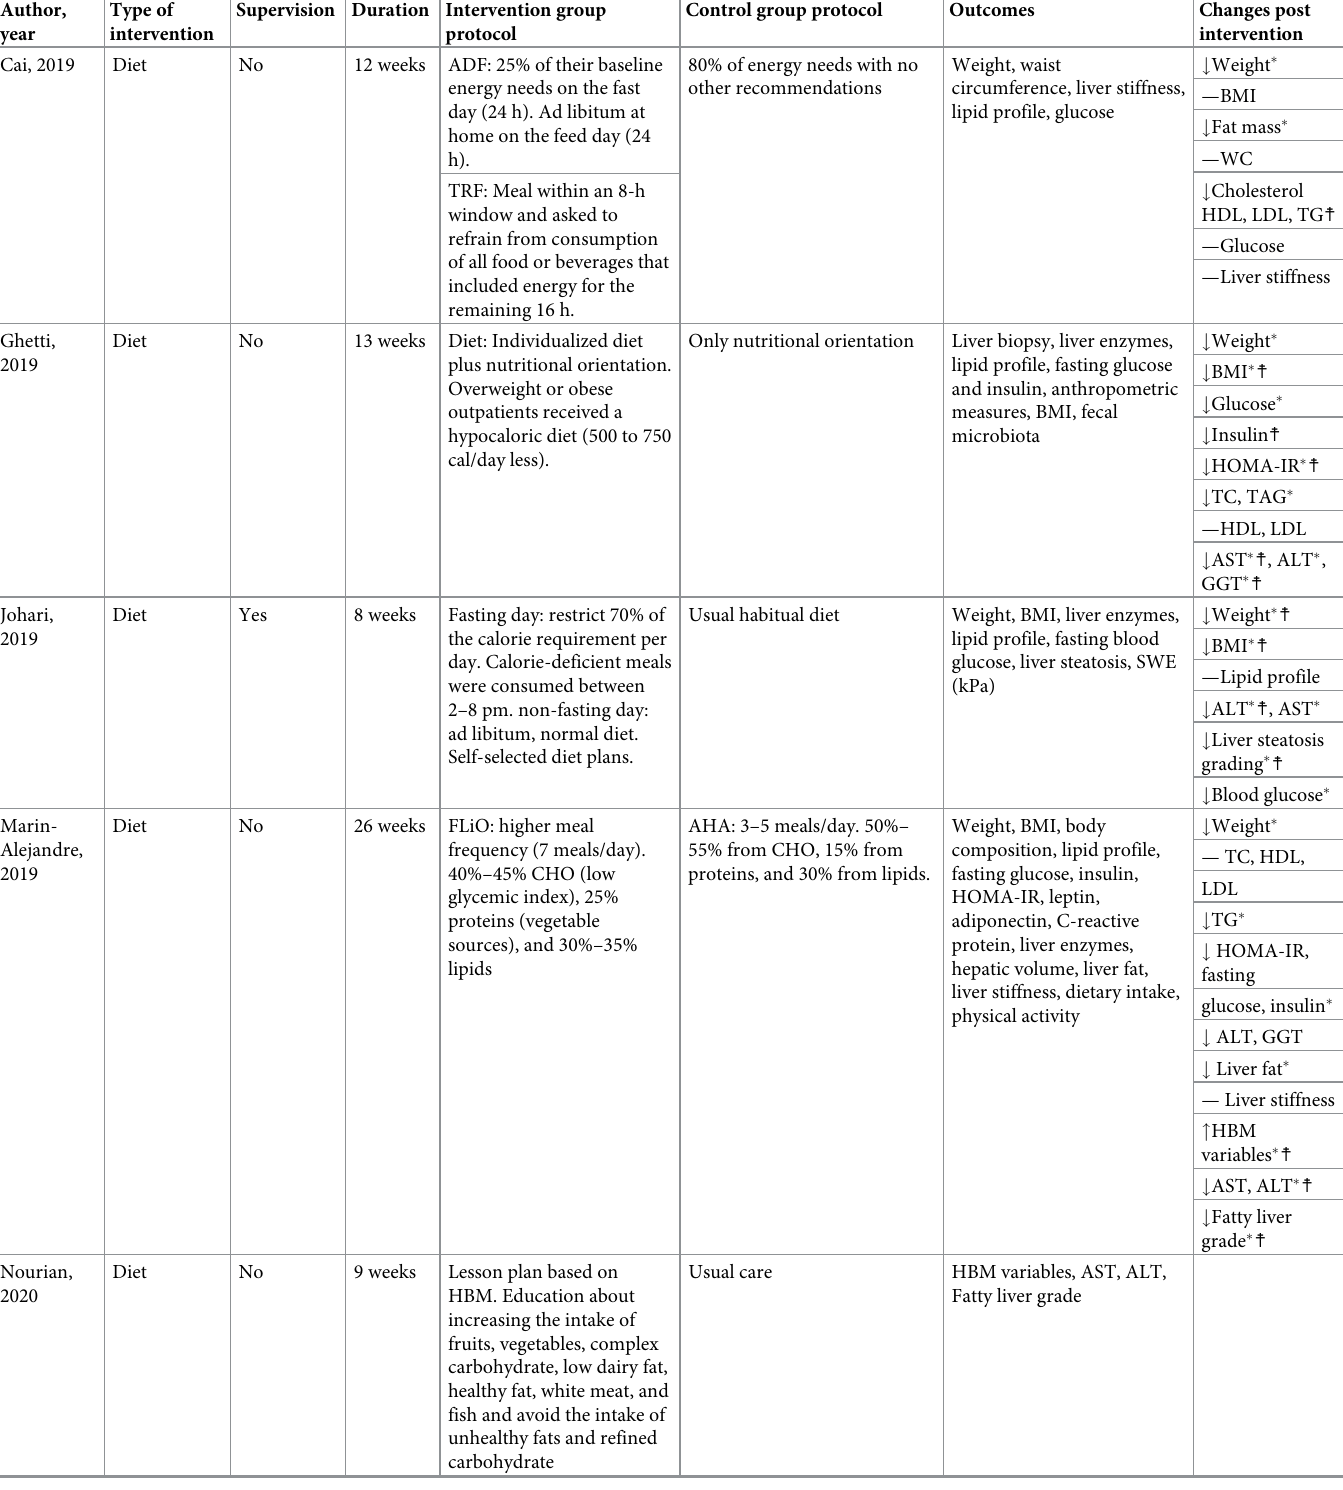
Table 3. Trials evaluating diet alone in NAFLD